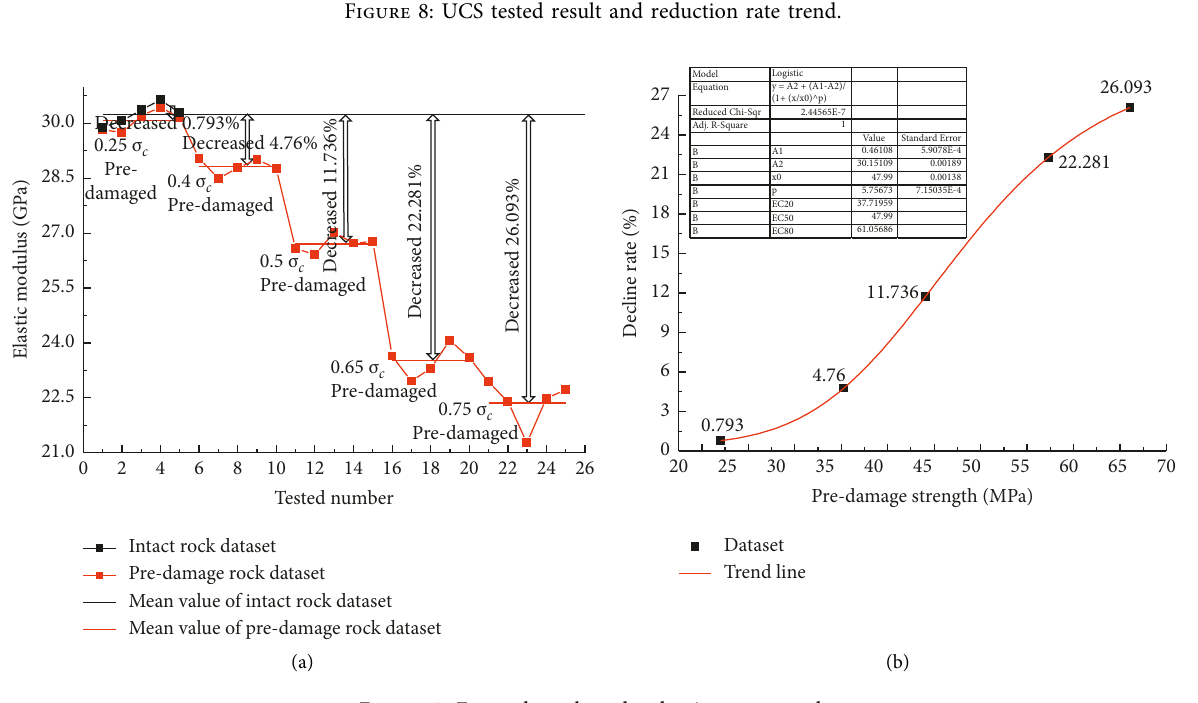
Figure 9: E tested result and reduction rate